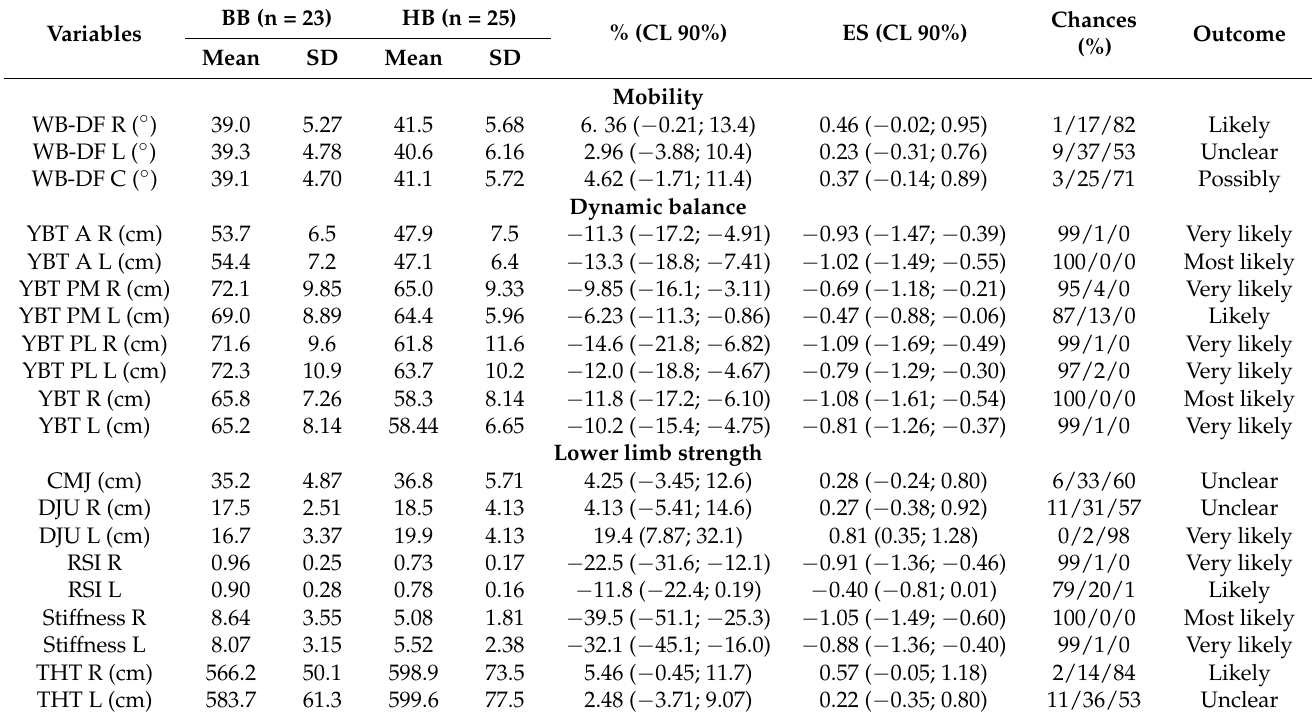
Table 2. Comparative analysis of mobility, dynamic balance and lower limb strength according to the type of sport.